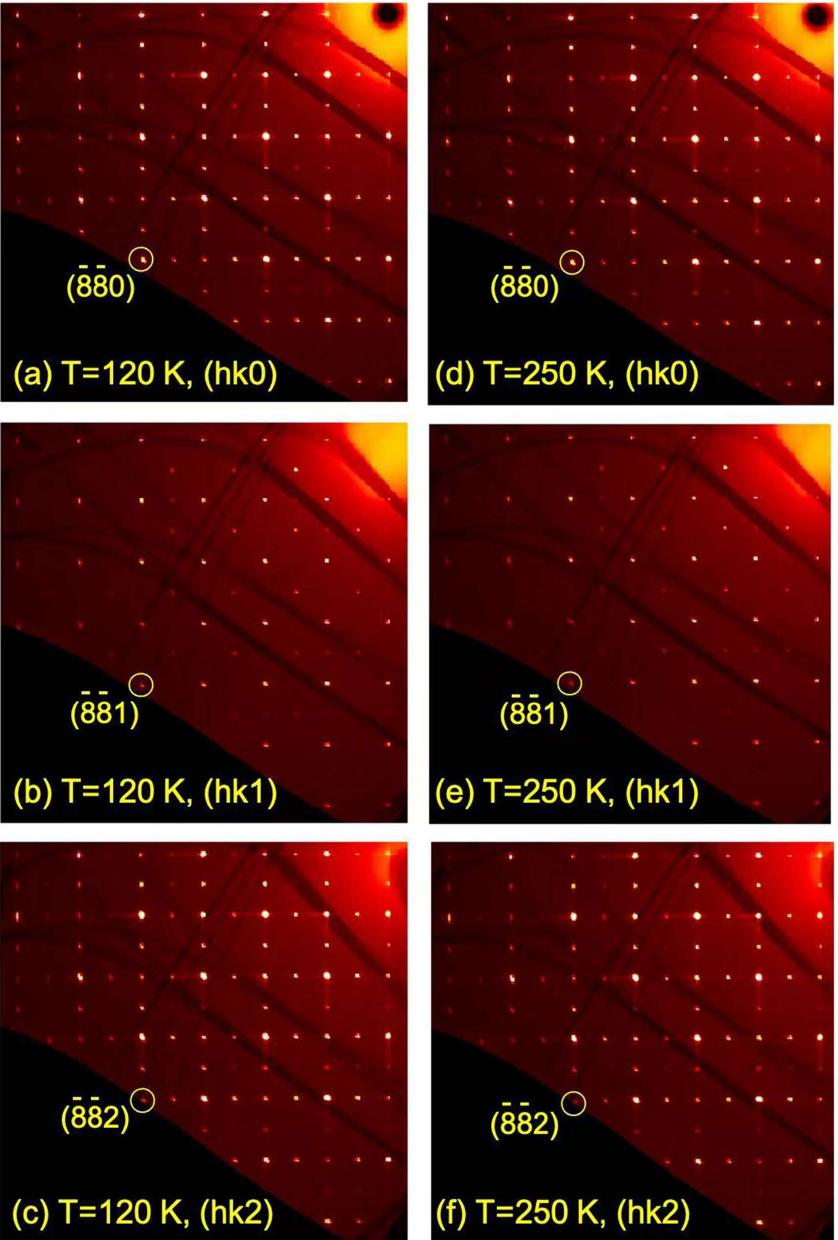
Figure 6. ( a ) Pseudocubic ( hk 0) planes ( a ~7.6 Å) of as-grown NdNiO 3 measured by single-crystal X-ray diffraction at 120 K; ( b ) Pseudocubic ( hk 1) planes at 120 K; ( c ) Pseudocubic ( hk 2) planes at 120 K; ( d ) Pseudocubic ( hk 0) planes at 250 K; ( e ) Pseudocubic ( hk 1) planes at 250 K; ( f ) Pseudocubic ( hk 2) planes at 250 K;